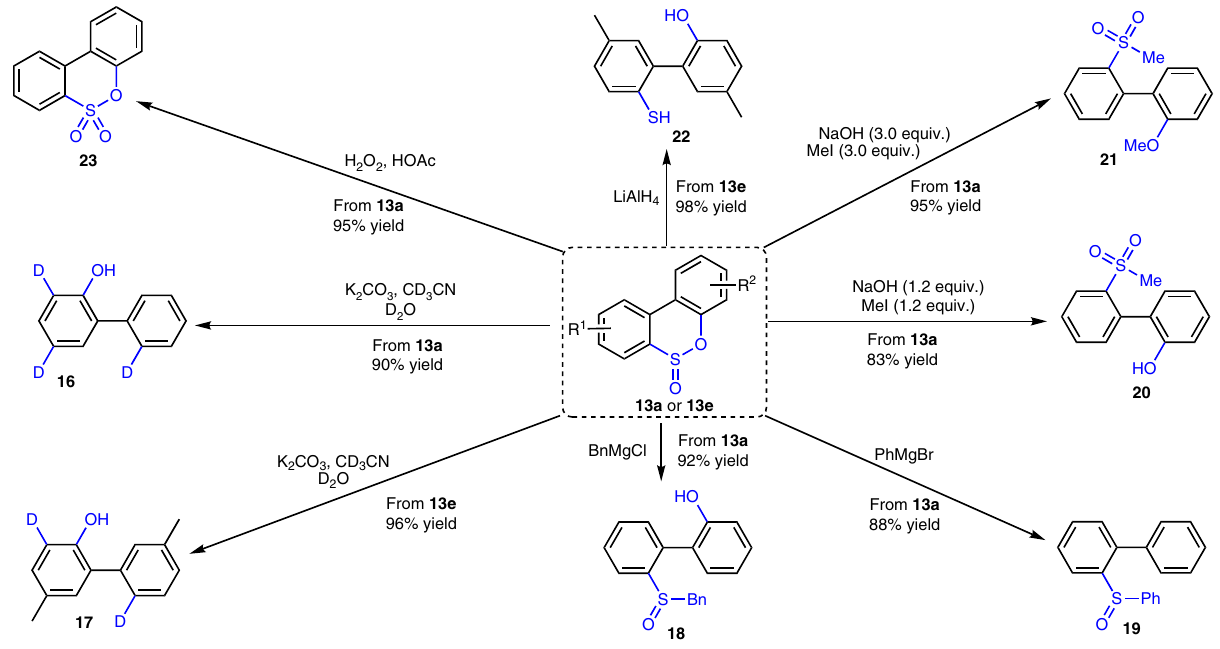
Fig. 4 Diverse transform of sul fi nic esters. Sul fi nic esters 13a and 13e were transformed to medicinally and synthetically useful products 16 – 23